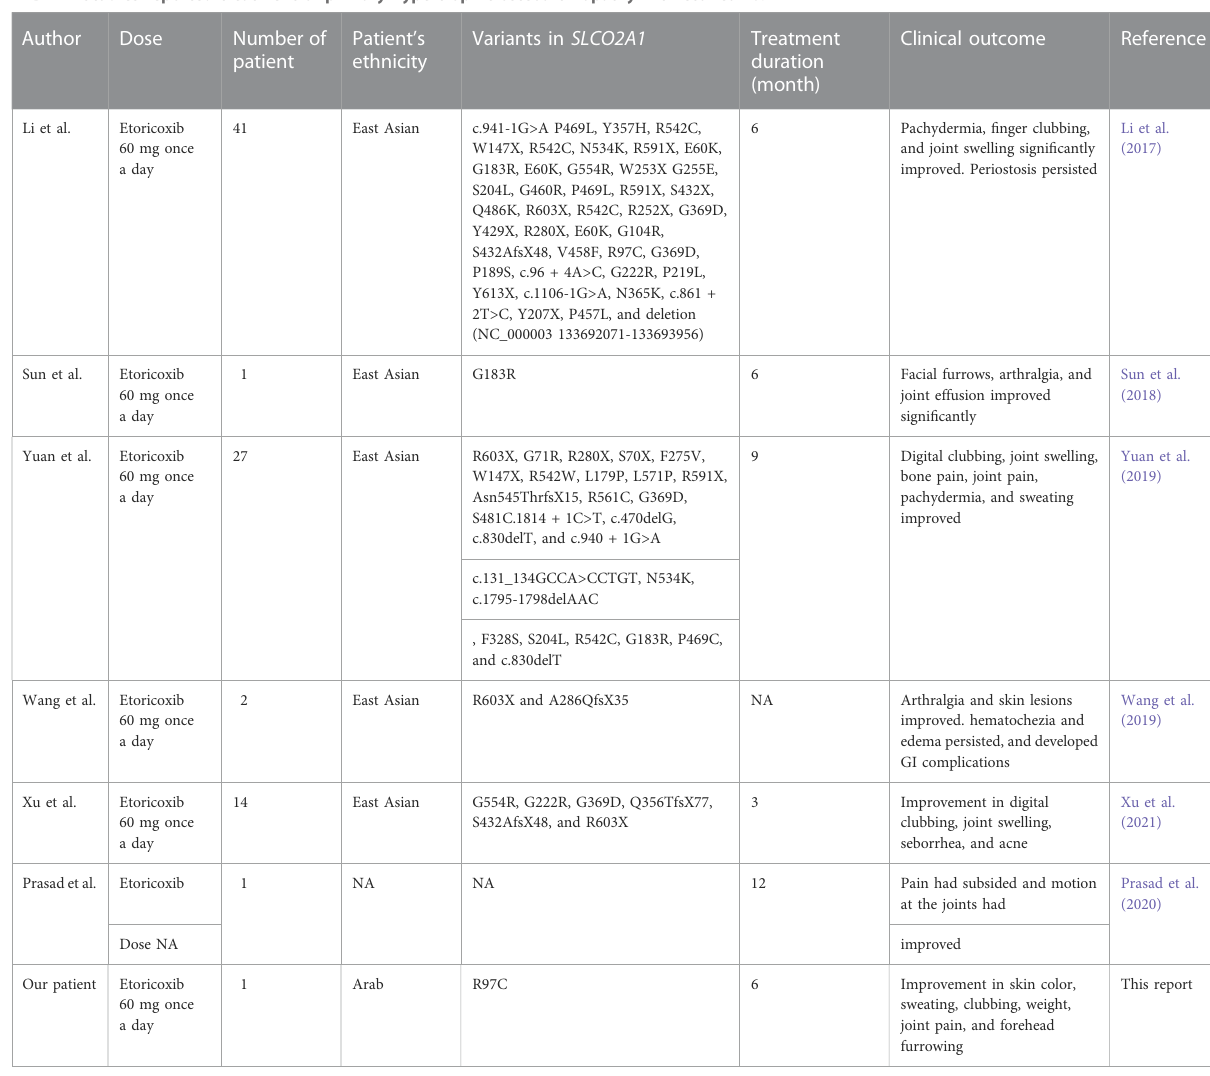
TABLE 1 Studies reported treatment of primary hypertrophic osteoarthropathy with